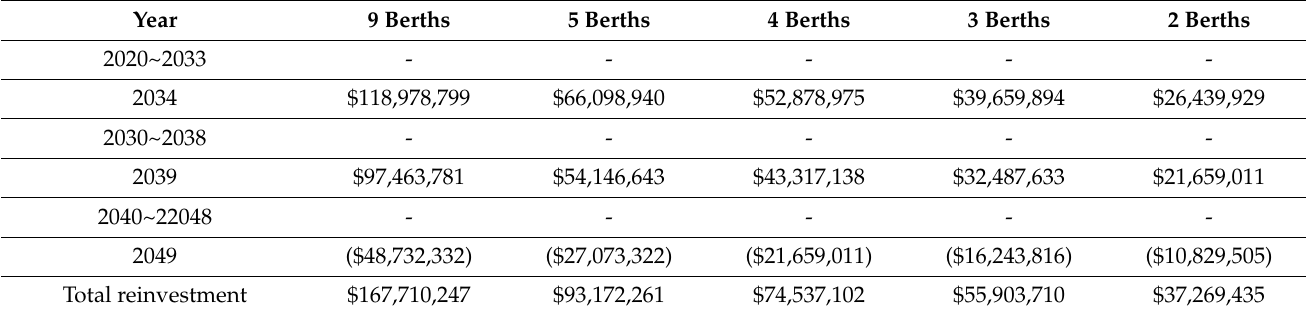
Table 15. Reinvestment and residual value from 2020 to 2049 (unit: U.S.